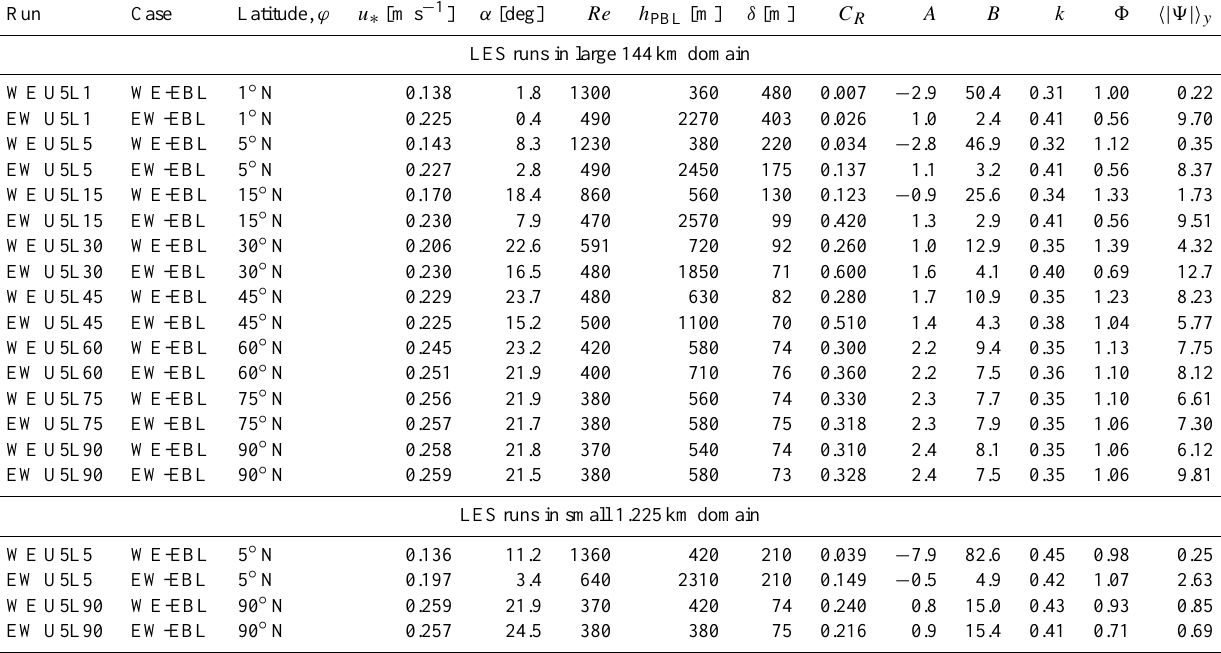
Table 1. Parameters of the large-eddy experiments with LESNIC. Internal EBL parameters are given at the sixth hour of integration. Run